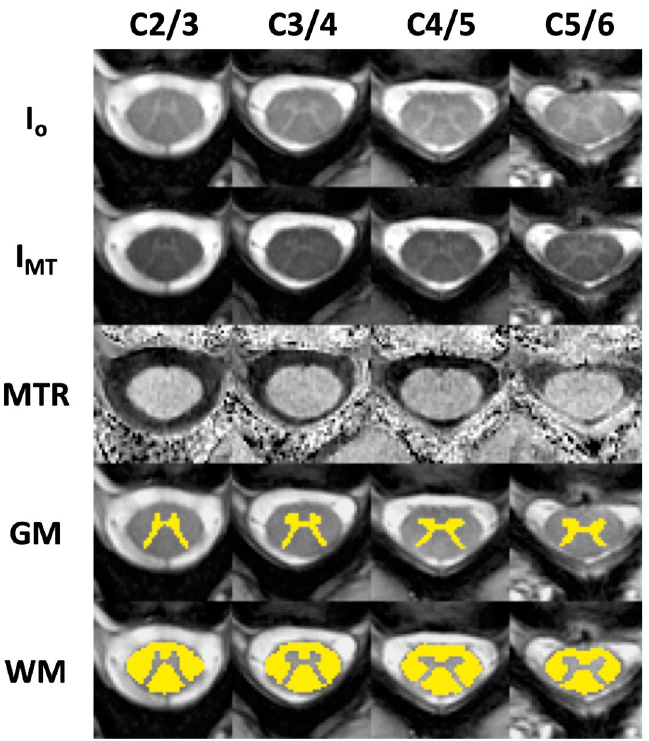
Figure 3. Example of co-registered images from C2/3, C3/4, C4/5, and C5/6 without and with magnetization transfer prepulse (respectively No MT and MT), magnetization transfer ratio (MTR) maps, and white (WM) and grey matter (GM) segmentations. MTR maps are shown scaled to minimum and maximum values within the spinal cord white